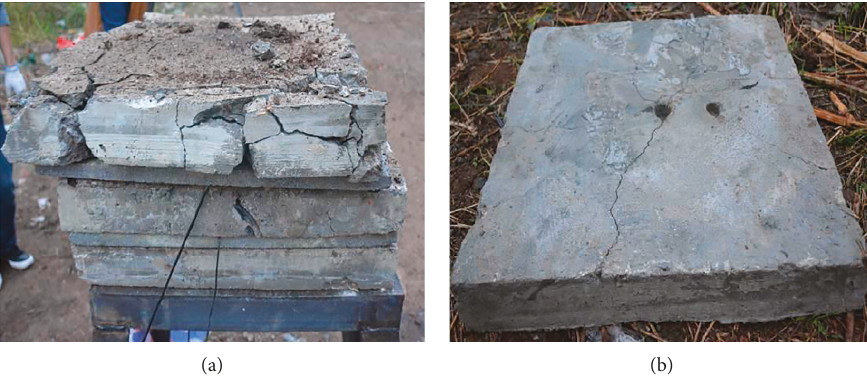
Figure 18: Complete setup for Test 5 (a) and the damage to the back of the base (b).